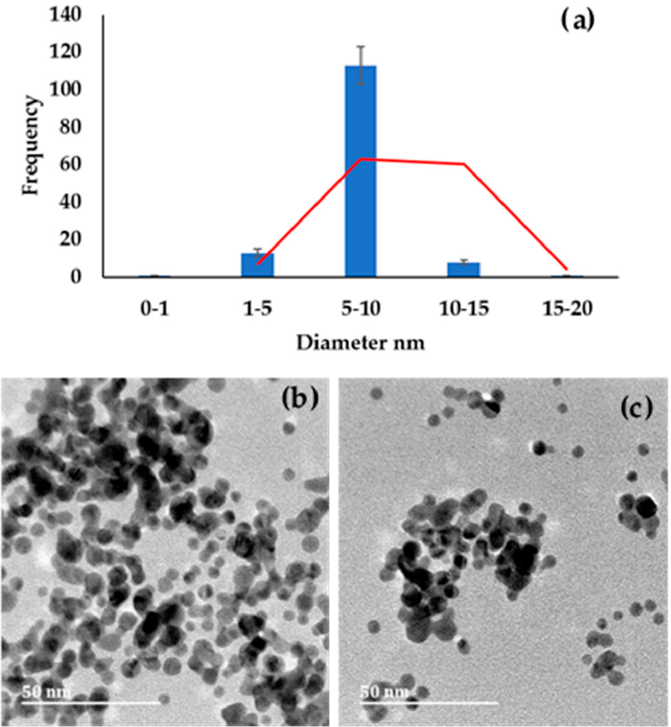
Figure 2. ( a ) Histogram obtained by measuring the diameter of AuNPs; ( b , c ) HRTEM images of sodium borohydride AuNPs. The use of ascorbic acid in the synthesis AuNPs resulted in the generation of nano ‐ particles (ASCB ‐ AuNPs) with a diameter between 5 and 15 nm. The HRTEM images and the plot of the particle size distribution of the NPs’ diameters are presented in Figure 3. The results show that the synthesized ASCB ‐ AuNPs are spherical, but clustered due to uncontrollable agglomeration, even in the presence of tri ‐ sodium citrate as the capping agent to induce stability. Their diameter range was between 1 and 20 nm, with an average size of 12 nm, as shown in Figure 3a. These results are comparable to those reported in the literature [32].